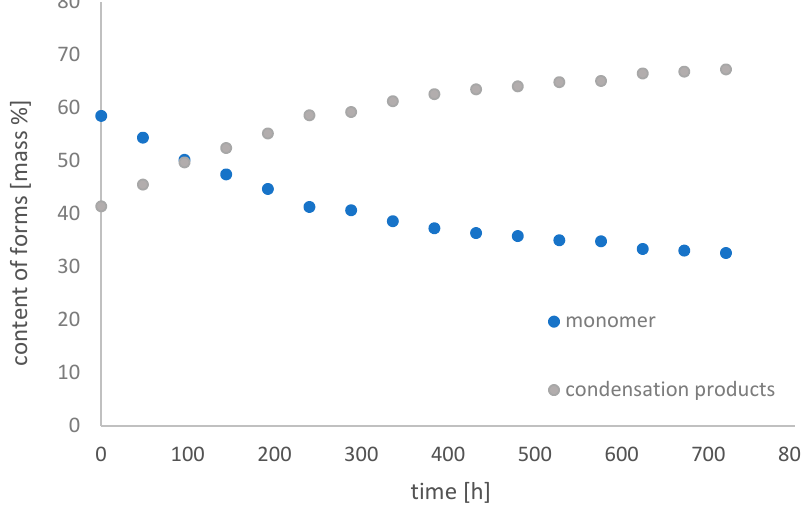
Figure 11. Change in the content of iron(III) ethylenediamine- N,N ′ -di[(2-hydroxy-5- sulfophenyl)acetic acid] forms with time in an aqueous solution at pH 3.